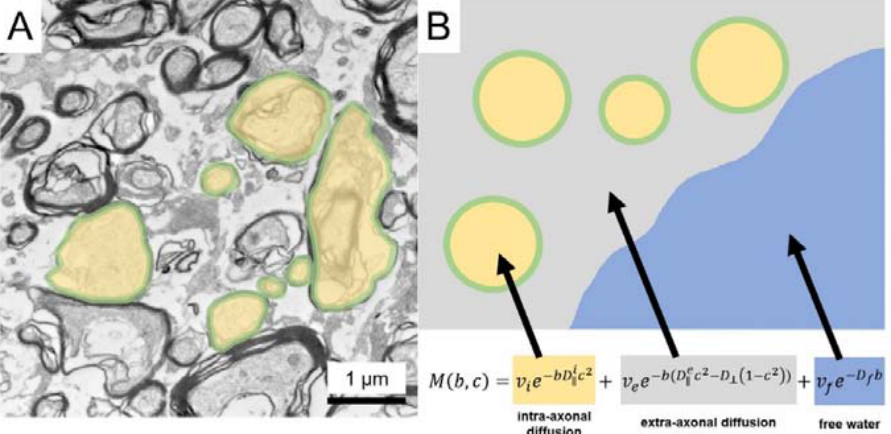
Figure 1. MR ‐ physical concept of diffusion microstructure imaging. White ‐ matter electron microscopic (60 nm ultrathin sections) ( A ) and schematic representation ( B ). Briefly summarized, the microstructure model can be traced back to a 3 ‐ compartment model in which D and v describe the diffusivities and the volume fractions of the corresponding compartments, where the subscript i refers to the intra ‐ axonal compartment, e to the extra ‐ axonal compartment, and f to the free water compartment. Visualization of the extra ‐ axonal and free water compartments are anatomically compromised by preparation artifacts in electron microscopic sections ( A ). With permission by [19].